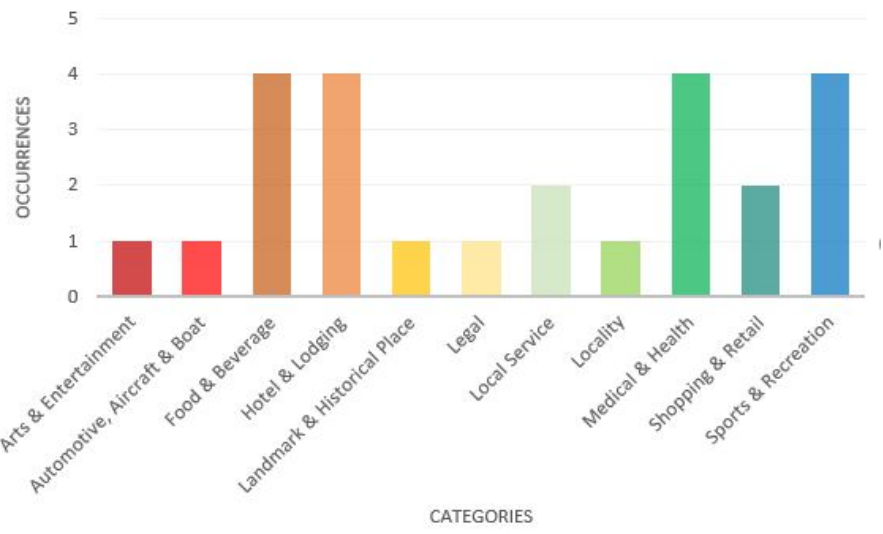
Figure 5. Histogram of high-level categories present in the example antenna of Figure 4. As this process was repeated with other antennas, subjecting them to the same evalua- tion, we find that the classifications obtained generally matched our expectations for that particular region. Although the Facebook Places dataset does not contain every existing POI, it contains enough relevant ones to capture the main activities or motivations that might lead an individual to a